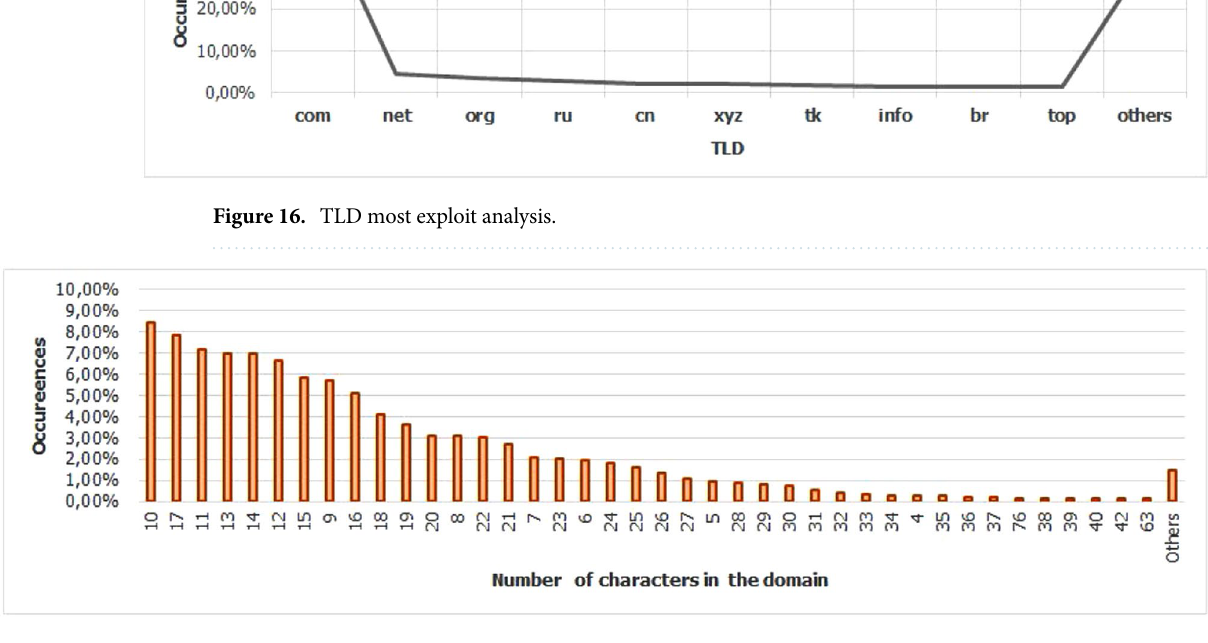
Figure 17. Domain length occurences.